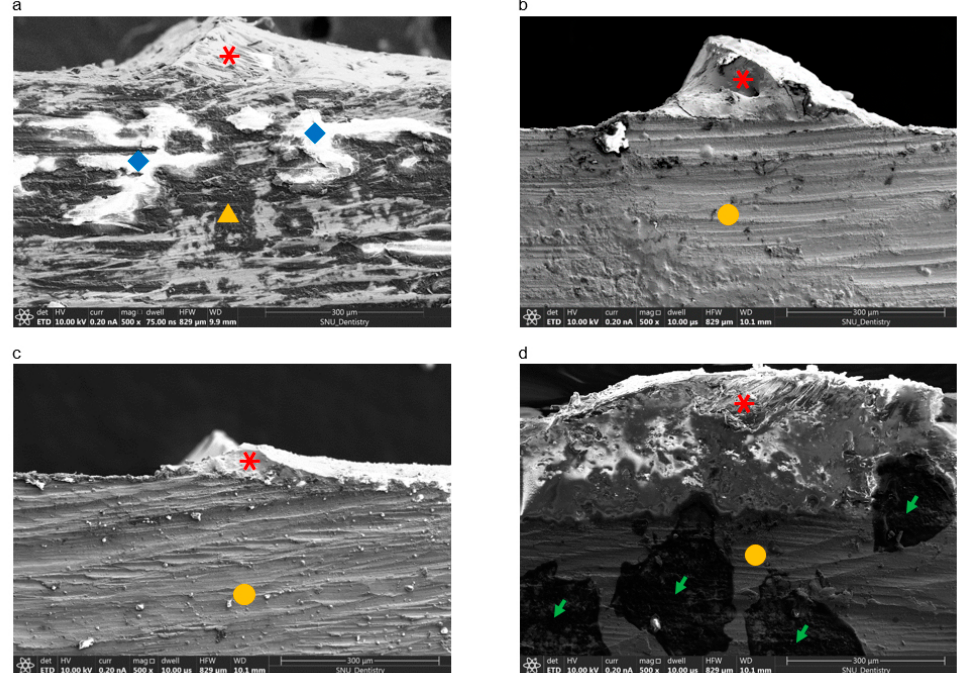
Figure 7. Scanning electron microscopy images (300 × ) of specimens after de-bonding of ceramic from the Co-Cr alloy surface. ( a ) Casting group; ( b ) SLM-fabricated specimens without bonding agent; ( c ) SLM-fabricated specimens with bonding agent A; ( d ) SLM-fabricated specimens with bonding agent B. Red asterisks represent adherent ceramic. Yellow triangles show Co-Cr substrate fabricated by casting, and yellow circles indicate Co-Cr alloy fabricated by SLM. Blue diamonds indicate wash opaque from ceramic on the Co-Cr substrate, while green arrows indicate remnant Au from sputtering.